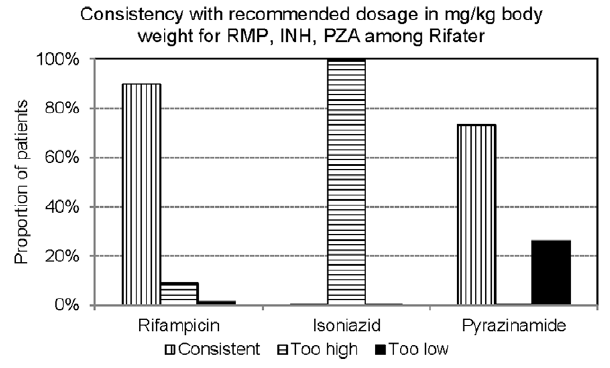
Figure 3. Consistency with recommended dosage in mg/kg body weight for Rifampicin 8 – 10 mg/kg), Isoniazid (4 – 6